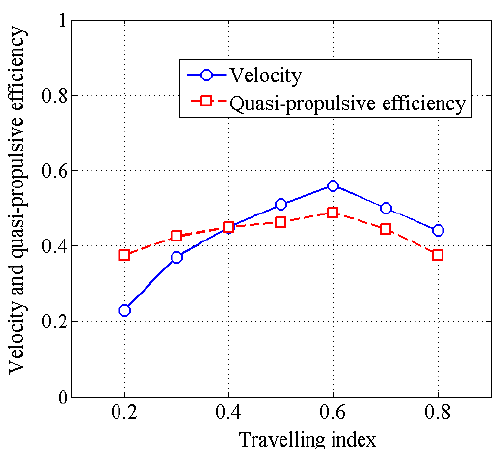
Figure 11. Effects of travelling index on the swimming performance of carangiform fish.